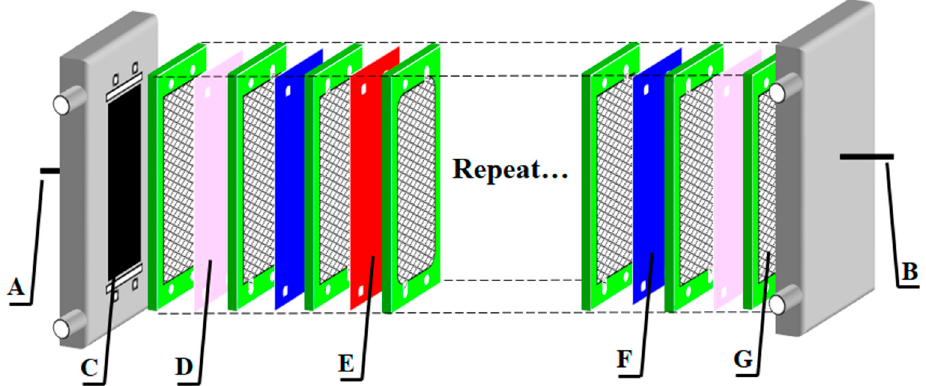
Figure 1. Internal structure of the electrodialysis (ED) membrane stack. ( A ) cathode; ( B ) anode; ( C ) electrode; ( D ) special cation exchange membranes (CEM); ( E ) CEM; ( F ) anion exchange membranes (AEM); ( G ) compartment.